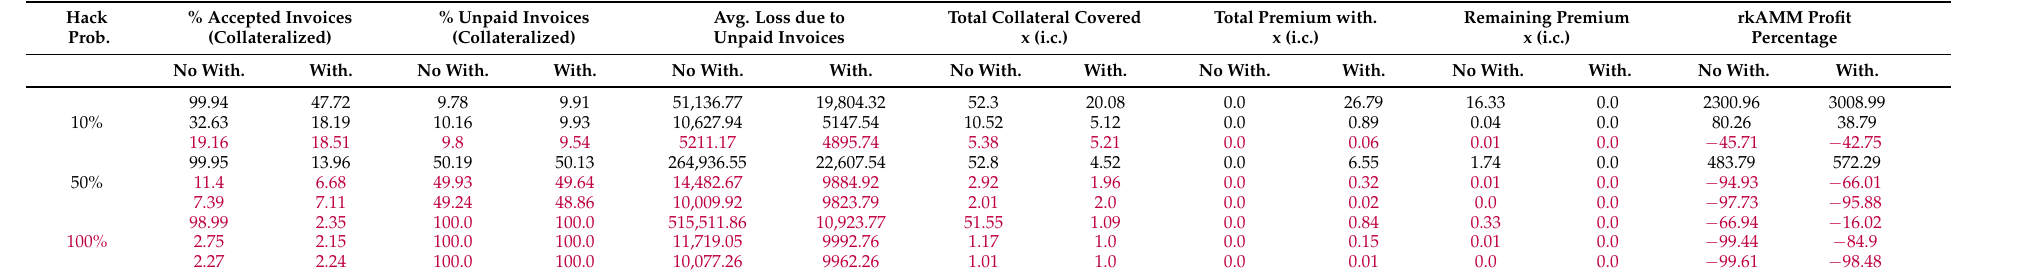
Table 10. rkAMM hack scenario results. Every day, 50% of the premium obtained is